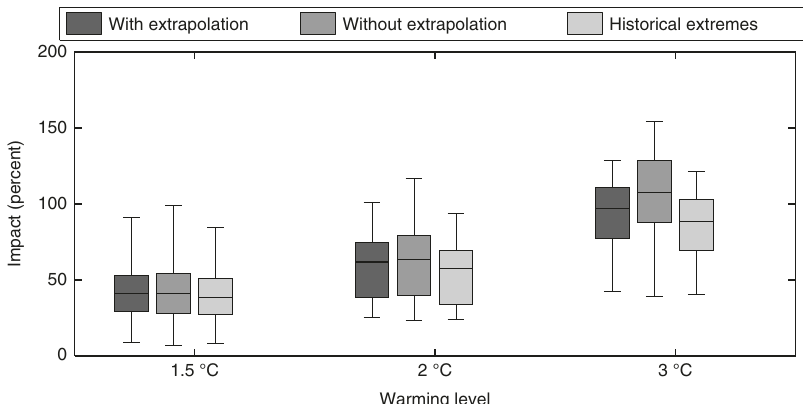
Fig. 6 Sensitivity analysis of the burned area changes in Mediterranean Europe based on extrapolation. Burned area changes (in %) are shown for each warming level considering the non-stationary model NSM (i.e., using Eq. 4). Boxplots show the uncertainty from both RCM and regression model uncertainties (1000 bootstrap replications × the ensemble of RCMs) if predictors are allowed to exceed historical extremes (i.e., with extrapolation, as in the previous analyses), if eco-regions with temperature projections exceed the range of historical values used for fi tting the relationship of Eq. 2 are excluded (i.e., without extrapolation) and if predictors are constrained to historical extremes. The median is shown as a solid line, the box indicates the